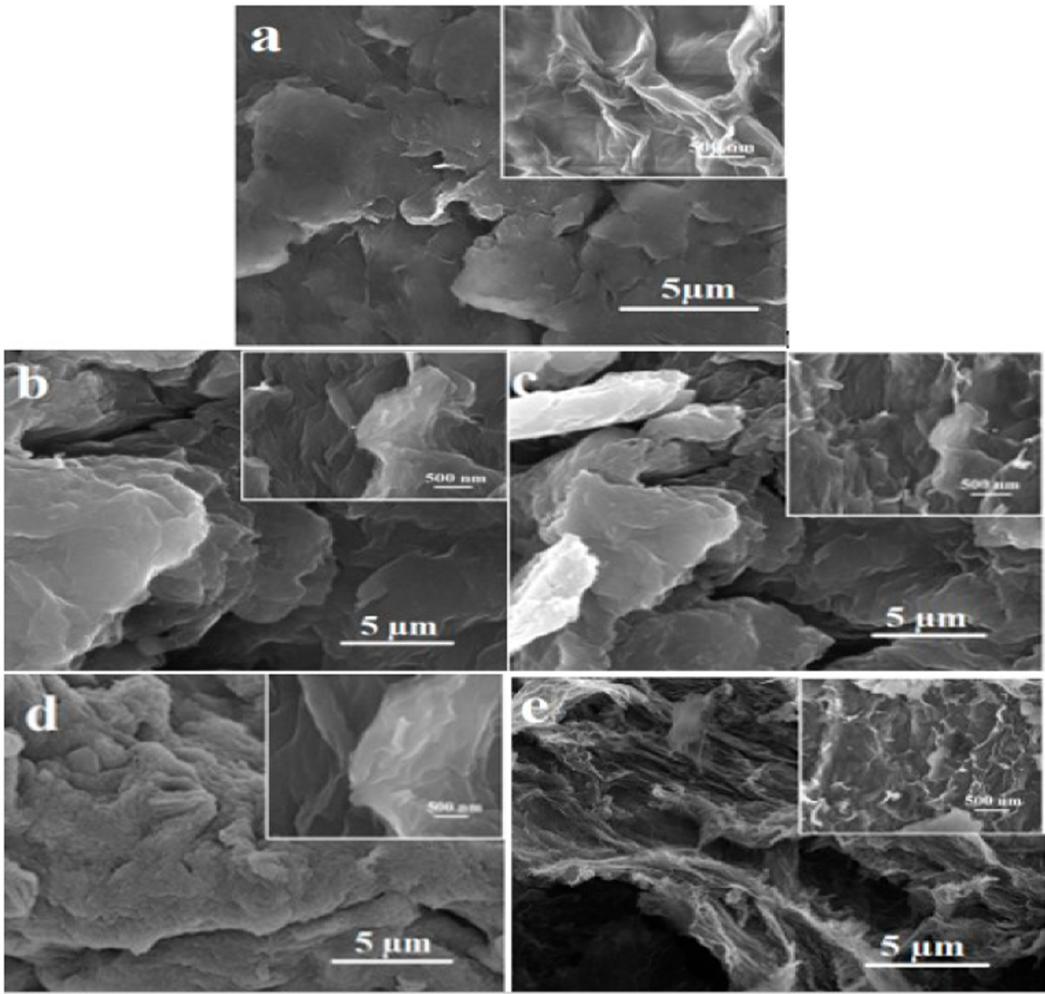
Figure 6. FE-SEM micrographs of ( a ) GO, ( b ) AGO-100, ( c ) GGO-100, ( d ) AGO-150, and ( e ) GGO-150.